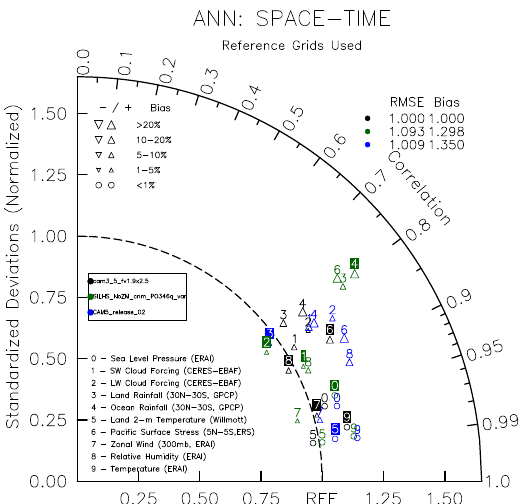
Figure 8. Taylor diagram with metrics for CAM 3.5 (black), CAM 5.3 (blue), and 2 ◦ CAM-CLUBB–SILHS (green). CAM- CLUBB–SILHS is competitive for all metrics except ocean and land rainfall, and Pacific surface